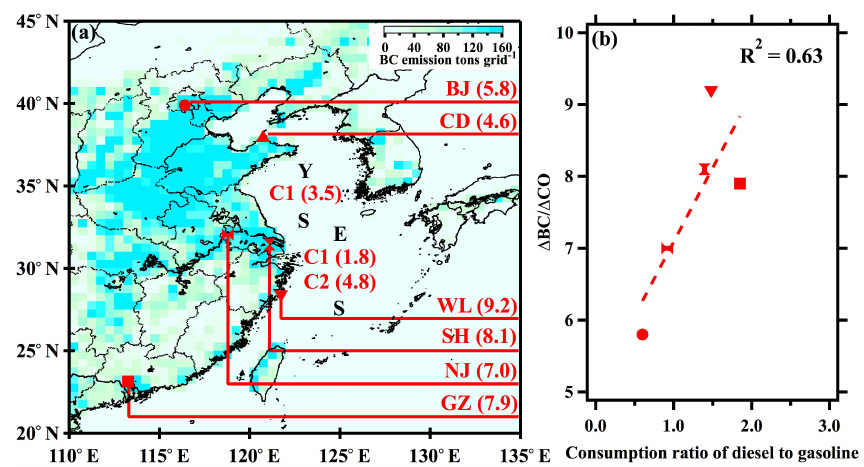
Figure 5. The (cid:49) BC /(cid:49) CO ratios in this study and other studies in East China (a) and their function of the ratios of diesel consumption to gasoline consumption in each province/city (b)